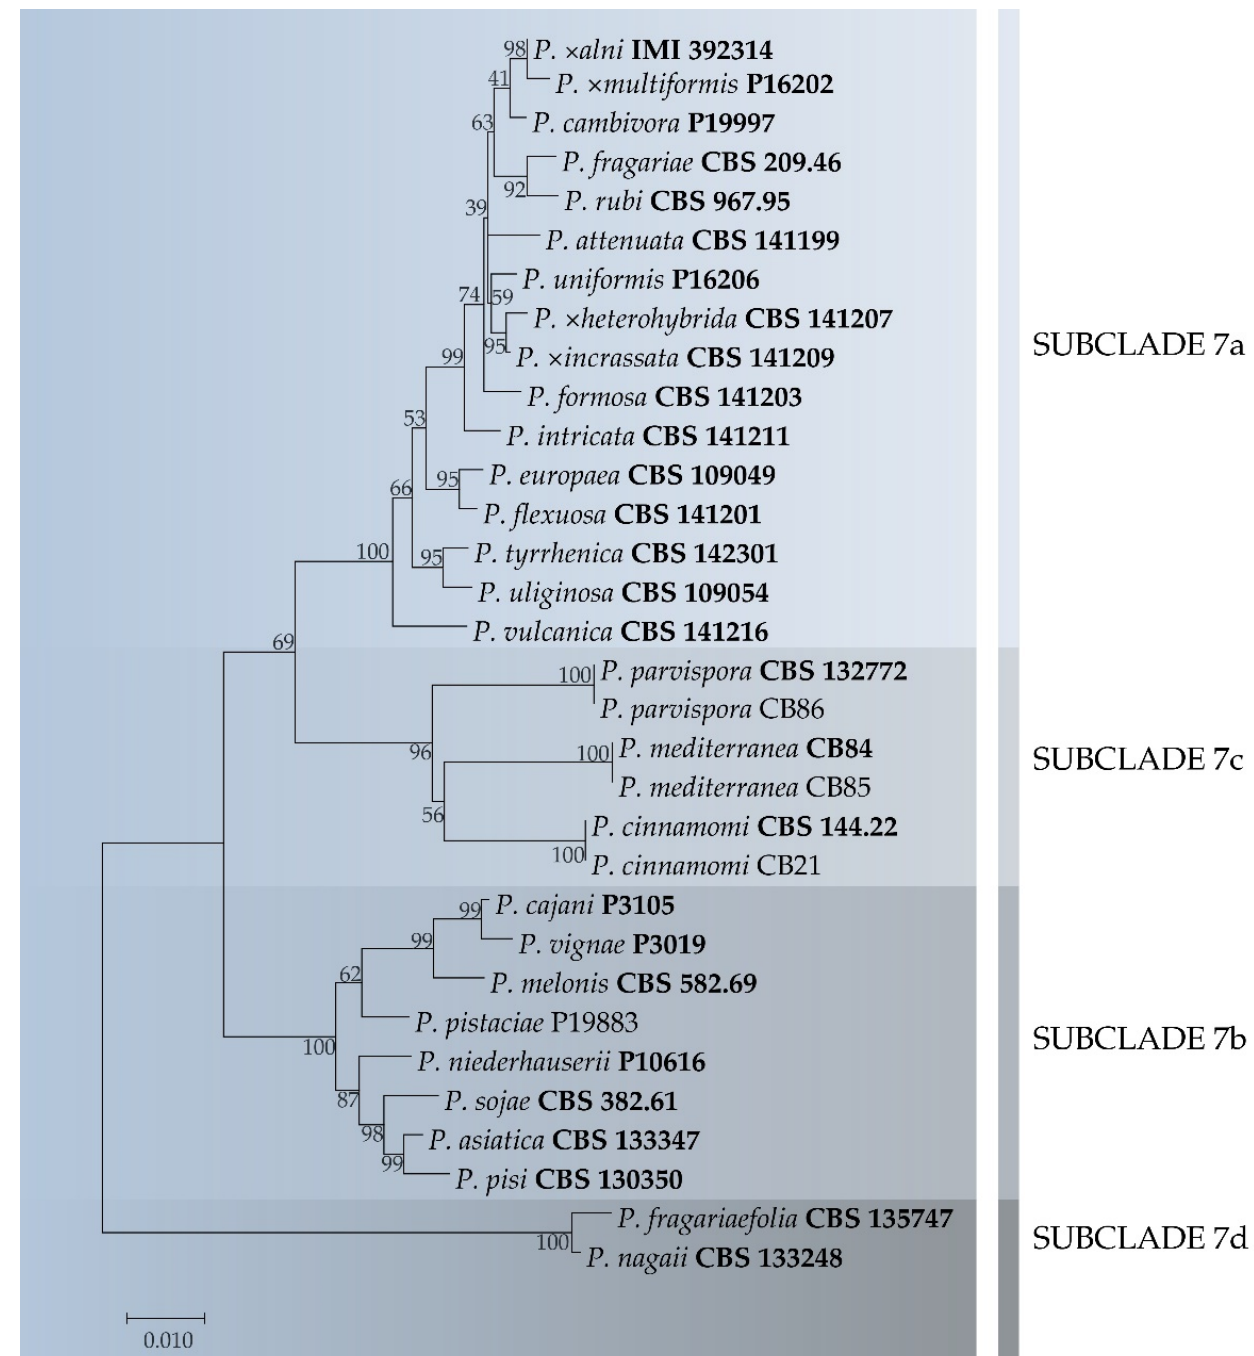
Figure 2. Maximum likelihood tree obtained from combined ITS, Btub and cox1 sequences of Phytophthora species belonging to clade 7. Data are based on the general time reversible model. A discrete gamma distribution was used to model evolutionary rate differences among sites. The tree is drawn to scale, with branch lengths measured in the number of substitutions per site. Bootstrap support values in percentage (1000 replicates) are given at the nodes. Ex-type cultures are reported in bold.